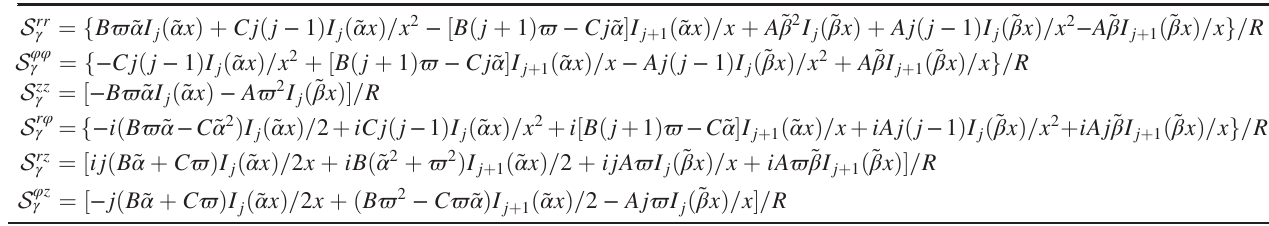
TABLE XV. Fiber eigenmodes: Components of the radial partial wave S γ of the strain modal field for the surface mode sector ω < ω The amplitudes A , B , C are determined by the boundary conditions Eq. (C20) and the normalization condition Eq. (C14). All remaining quantities are defined in Table